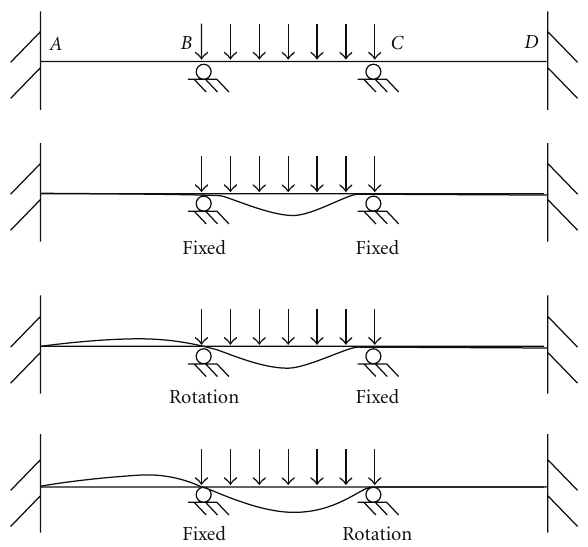
Figure 1: Continuous beam subjected to static loads.